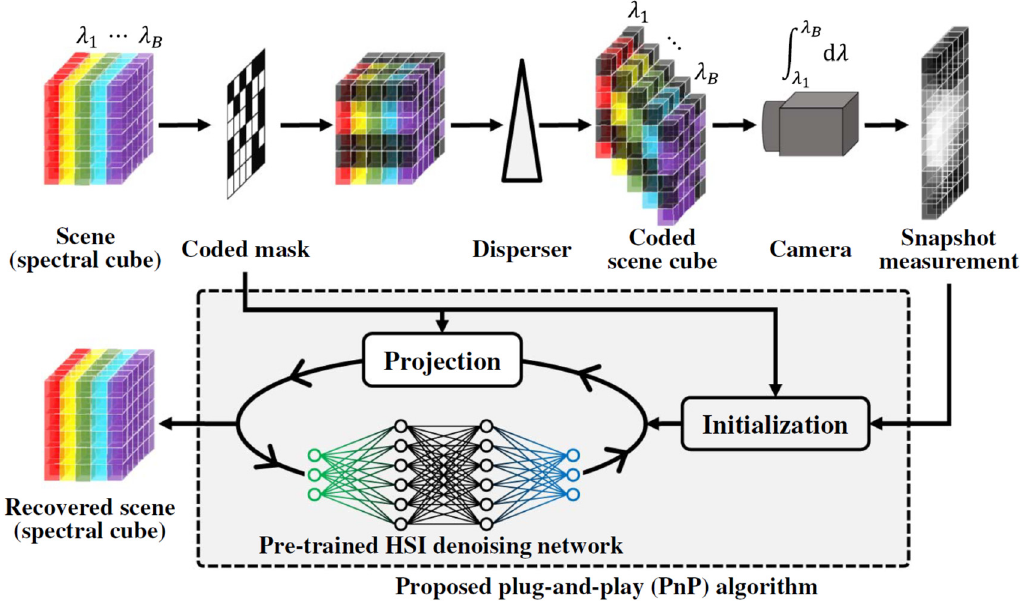
Figure 10: Image formation process of a typical spectral snapshot compressive imaging system, i.e., single disperser coded aperture snapshot spectral imaging and the reconstruction process using the proposed deep PnP prior algorithm. Figure is reprinted with permission from Ref. [119], copyright 2021 Optical Society of